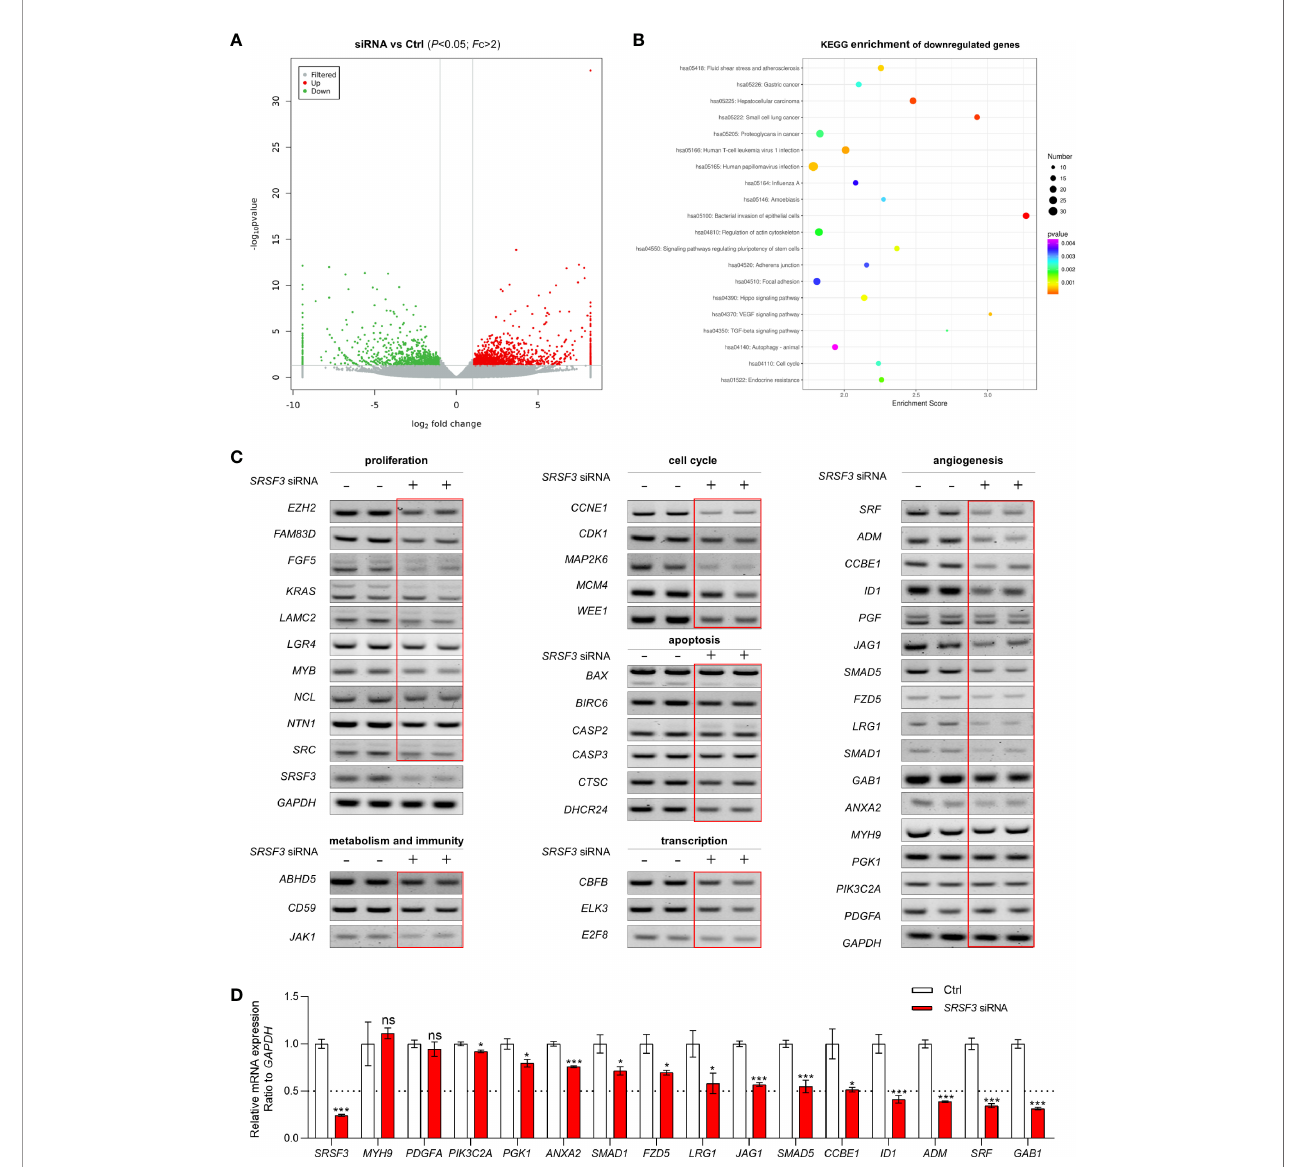
FIGURE 1 | The expression and function of SRSF3-regulated genes in HCT-116 cells. (A) Clustered heatmap for differentially expressed genes regulated by SRSF3. The gene expression was measured by RNA-seq. (B) KEGG analysis of the SRSF3-downregulated genes. (C) RT – PCR assays for SRSF3-regulated genes involved in various biological processes ( n =2). (D) qPCR assays for SRSF3-regulated genes related to angiogenesis ( n =6). Data represent mean±SD. Signi fi cance was assessed by two-sided t test . ***P <0.001; * P <0.05; ns, no signi fi